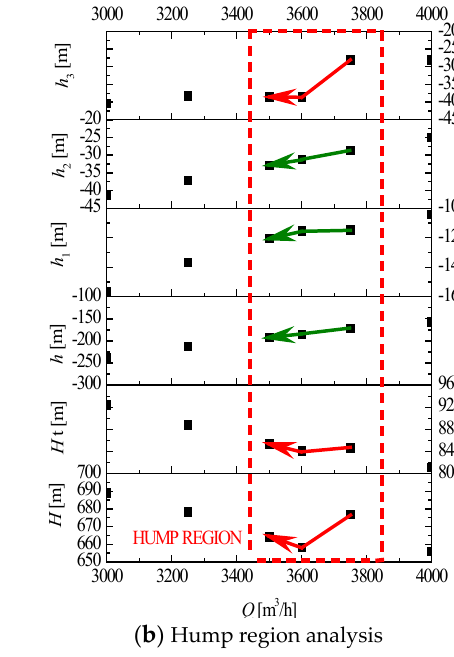
Figure 6. Analysis of H t and hydraulic loss.